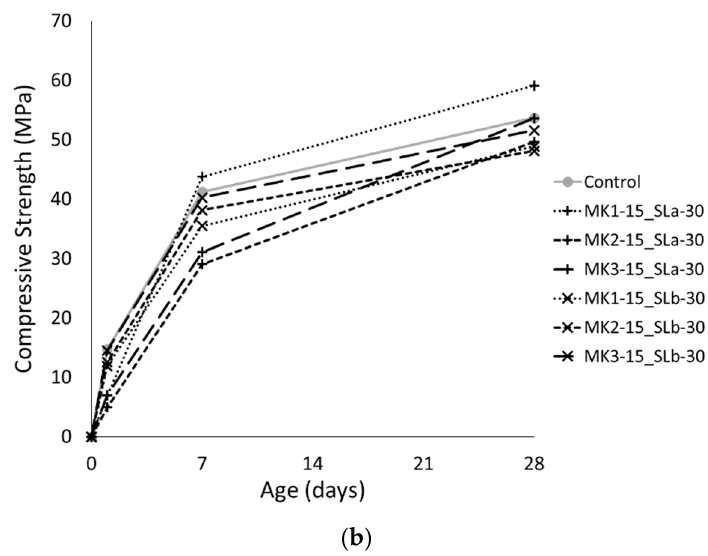
Figure 2. Compressive strength evolution for ( a ) non-metakaolin binary SCM, and ( b ) ternary SCM mixtures.